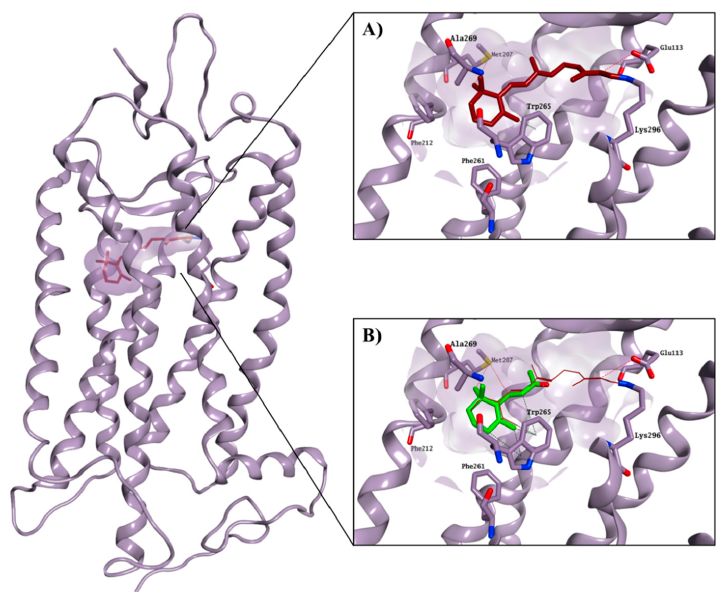
Figure 2. Crystal structure of bovine rhodopsin in complex with cocrystallised 11- cis -retinal (carbon atoms in garnet; ( A )), and with predicted binding mode for β -ionone (carbon atoms in green; ( B )). The binding site area is represented as the molecular surface. Rhodopsin is represented as the lilac ribbon. The ribbon for residues 261–271 and 289–295 is hidden for clarity.